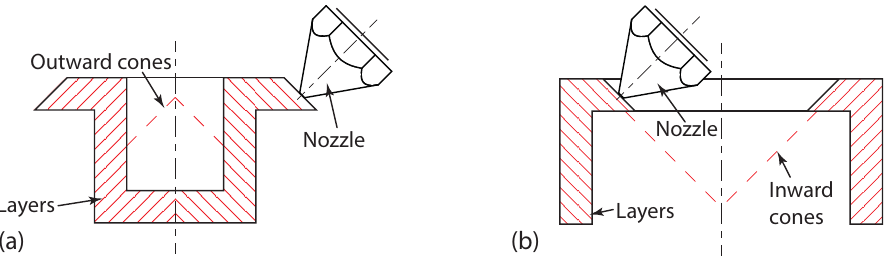
Figure 2. Depending on the direction of the overhangs, a different cone has to be chosen: ( a ) An outward cone for parts with overhangs towards the outside and ( b ) an inward cone for overhangs towards the inside.